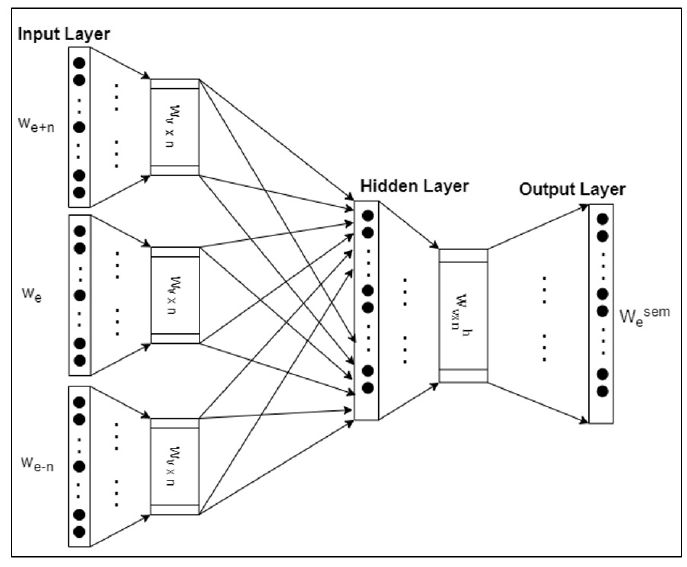
Figure 3. CBOW model for generating W sem e